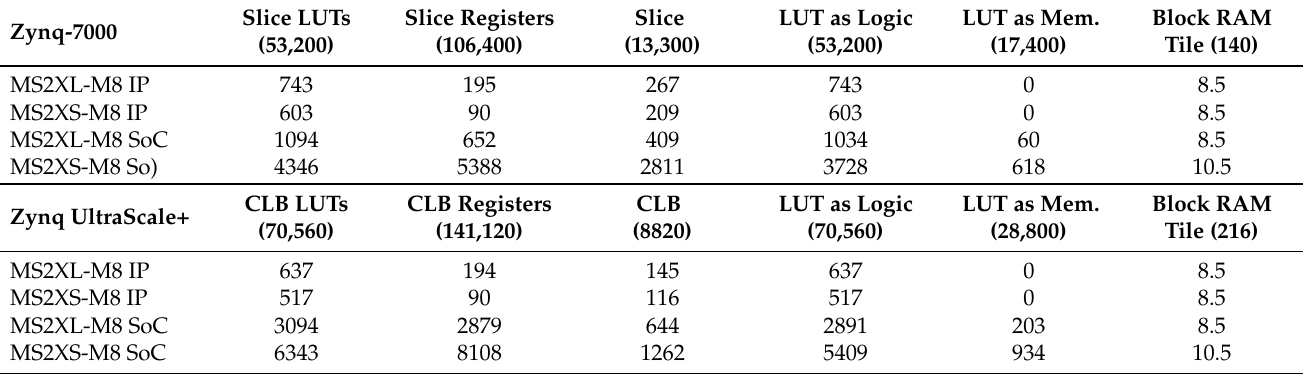
Table 2. Resources consumed by test systems using the two proposed multipliers with a multiplicity degree of 8 to implement the EES541EP1 parameter set on devices from the Xilinx Zynq-7000 and ZynqUltraScale+